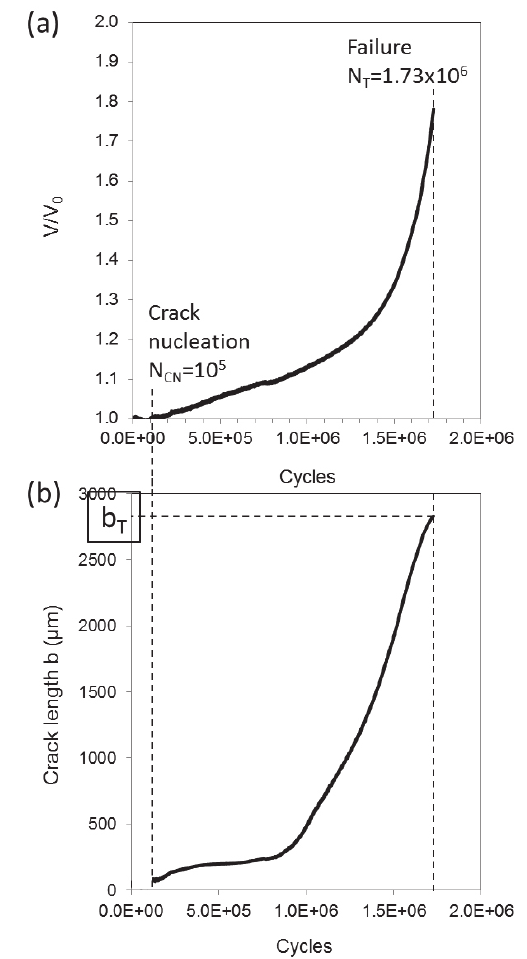
Figure 4: (a) Potential as a function of the number of cycles, (b) crack length as a function of the number of cycles calculated with the calibration curve. (R=4.6mm, P, σ F,moy / σ y,flat =0.78, R F =0.85,